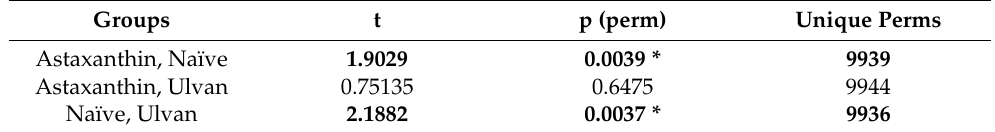
Table 3. Pairwise comparison tests between groups. Bold values marked as * are statistically significant based on p >